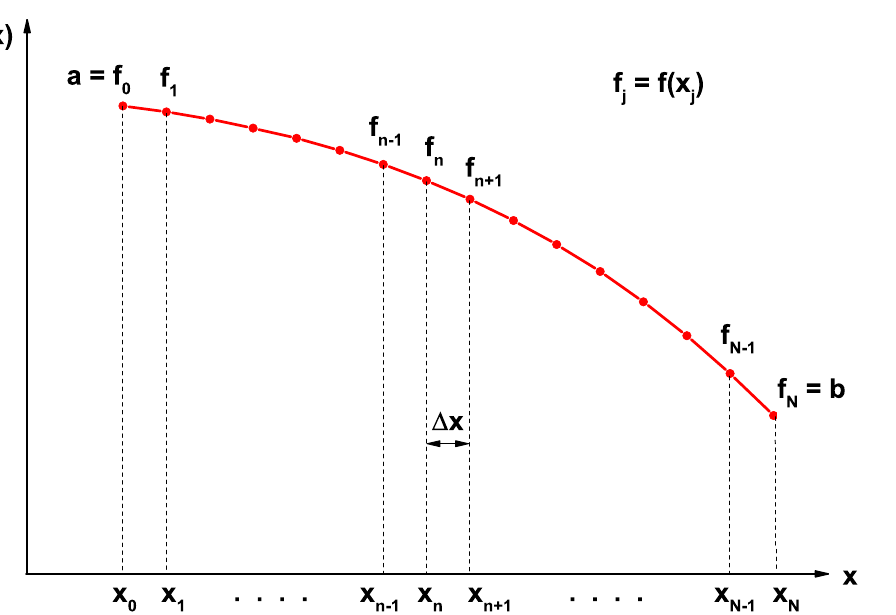
Figure 3. Representative schematic of a one-dimensional point mesh used to develop the finite difference